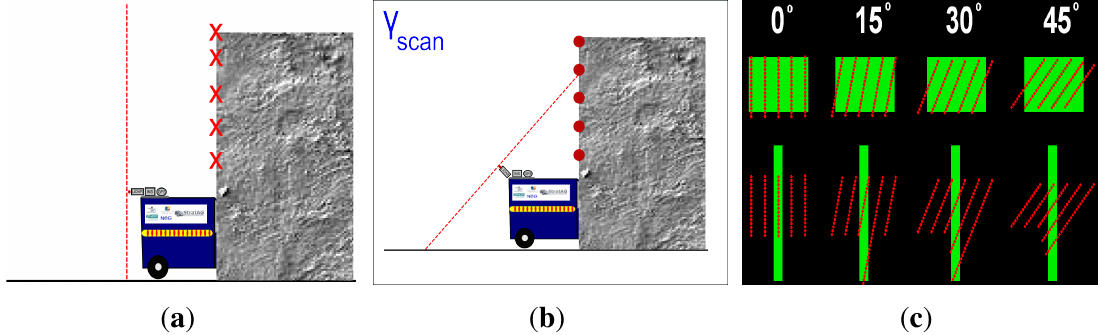
Figure 2. Issues relating to a vertical scanner inclination for an MMS: ( a ) no inclination results in zero pulses striking a perpendicular target overhead, ( b ) a vertical inclination ( γ now results in pulses striking the surface, ( c ) vertical inclinations result in more scan profiles intersecting with narrow vertical targets.